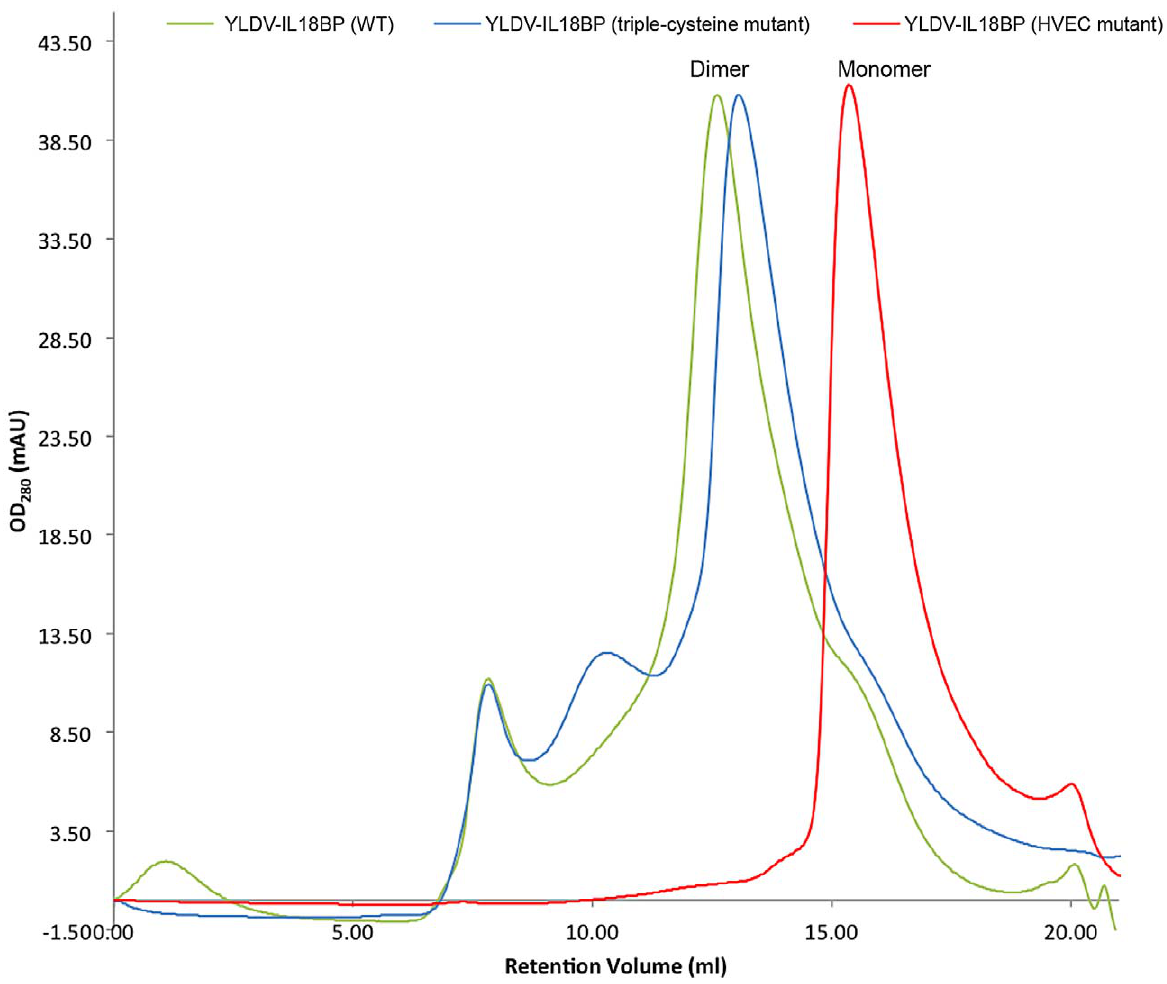
Figure 5. Size exclusion chromatography analysis of YLDV-IL18BP. Various SUMO fusion proteins containing WT, triple-cysteine ( D C21, C87S, C132S) mutant and the HVEC (H30A/V33R/E42R/C132S) mutant YLDV-IL18BPs were purified and analyzed on a Superdex S200 sizing column. Both WT (Green) and triple-cysteine mutant (blue) display as a dimer, with a calculated MW about 65 kDa estimated from the retention volumes. The HVEC mutant (red) displays predominantly as a monomer, with an estimated MW about 31 kDa. The minor peaks were identified from SDS-PAGE analysis as impurities unrelated to YLDV-IL18BP. doi:10.1371/journal.ppat.1002876.g005 Table 2. Kinetics and affinity constants of the binding of YLDV-IL18BP mutants with immobilized